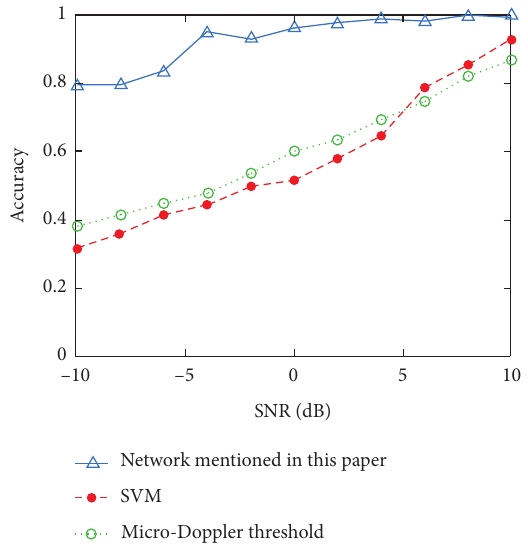
Figure 10: Recognition accuracy for different algorithms versus SNR.